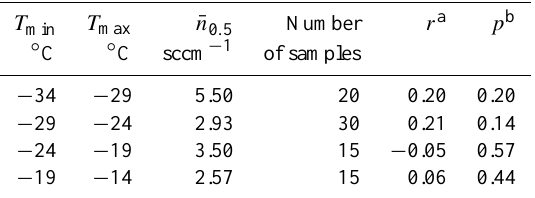
(cid:1) versus IC